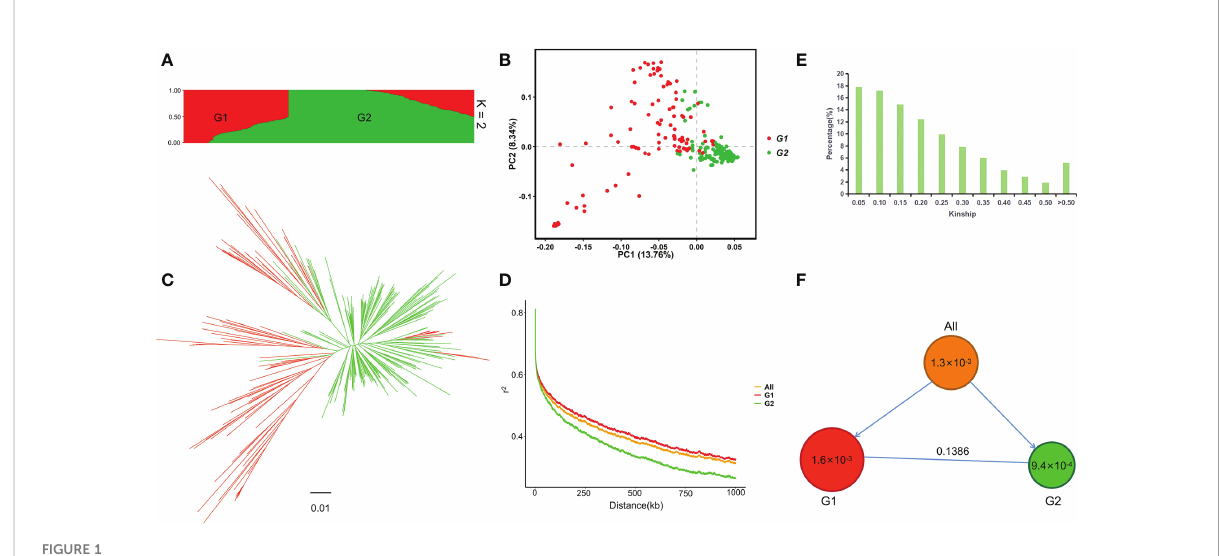
FIGURE 1 Population structure and genetic diversity in 313 japonica rice germplasm. (A) Population structure plot (K = 2). (B) PCA plot of the fi rst two principal components. (C) Phylogenetic tree based on genetic distance. (D) Genome-wide average LD map of all germplasm (All) and the G1 and G2 subpopulations. (E) Kinship plot. (F) Genetic diversity and subpopulation differentiation of 313 germplasm. Circle size and the number within each circle represent the genetic diversity ( p ) of each group. The arrows indicate that all germplasm are divided into two subpopulations; the number on the straight horizontal line represents F ST between the two